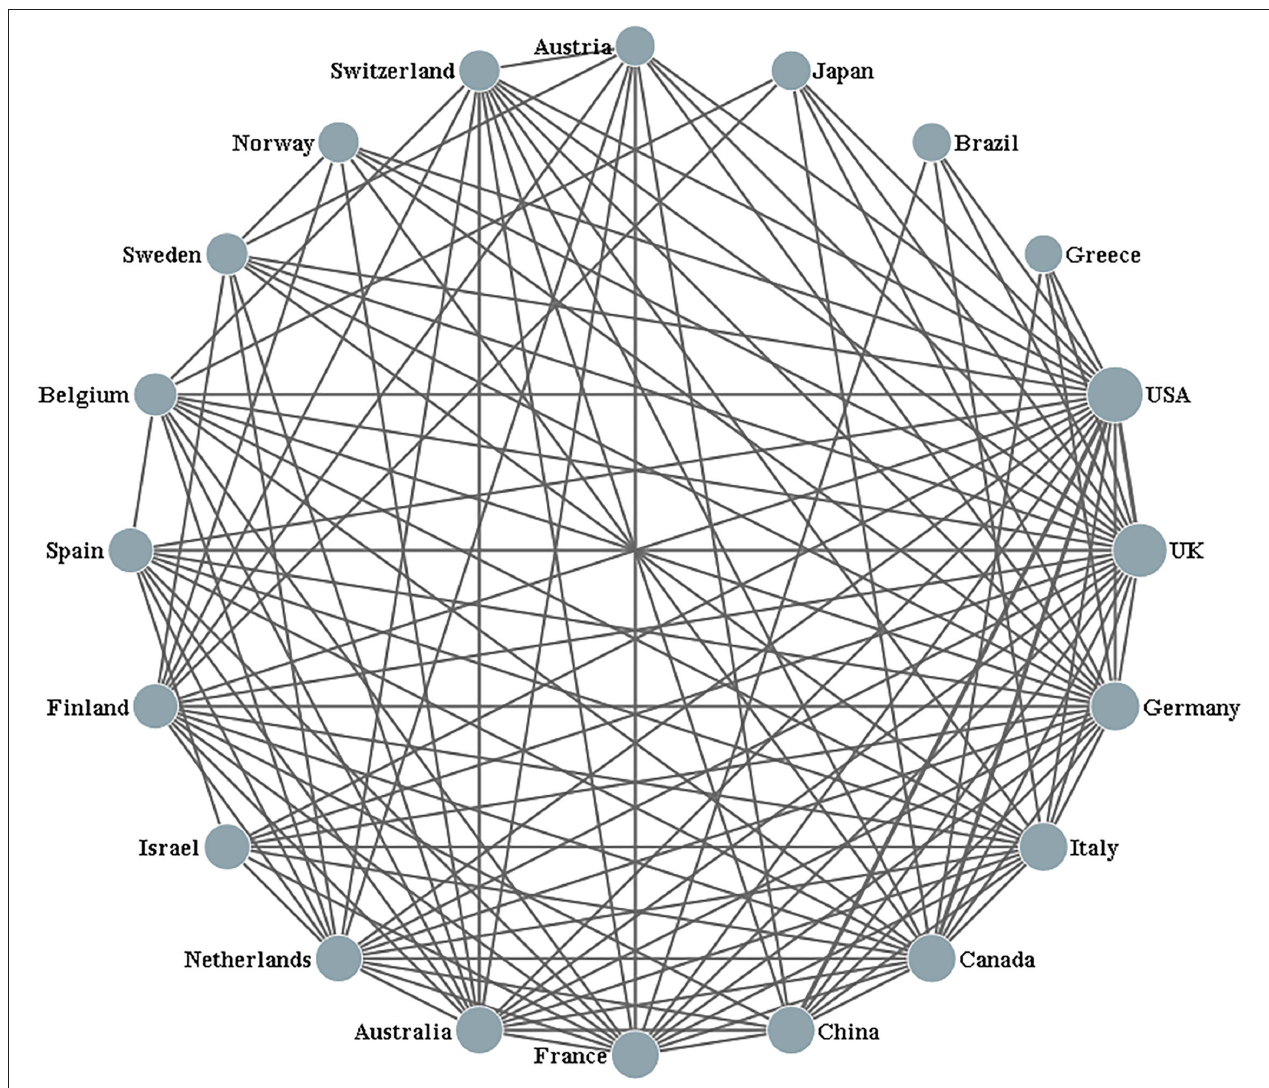
FIGURE 2 | Collaborative relationships among the top 20 most productive